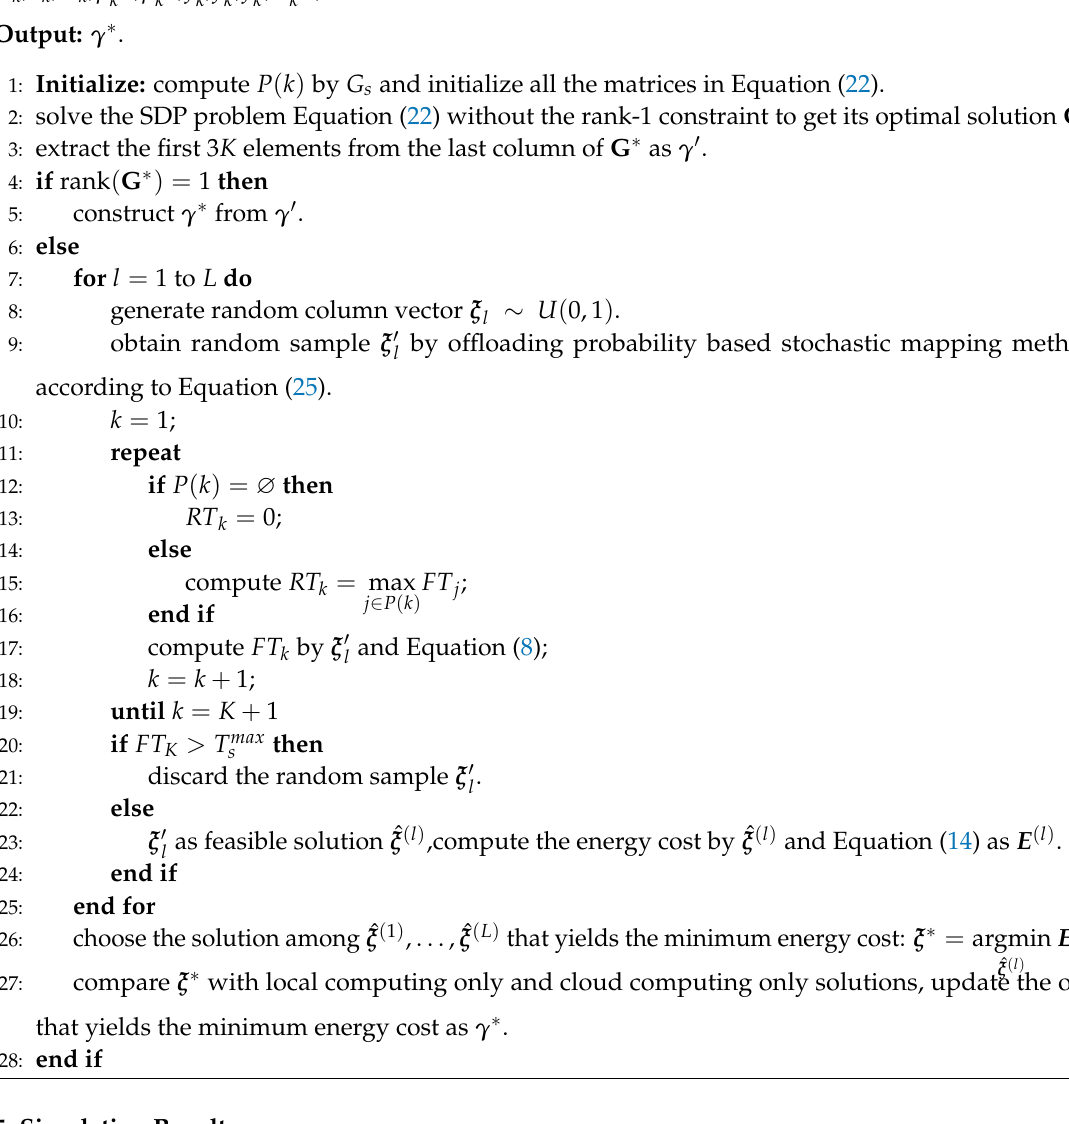
Algorithm 1 Proposed ECTCO